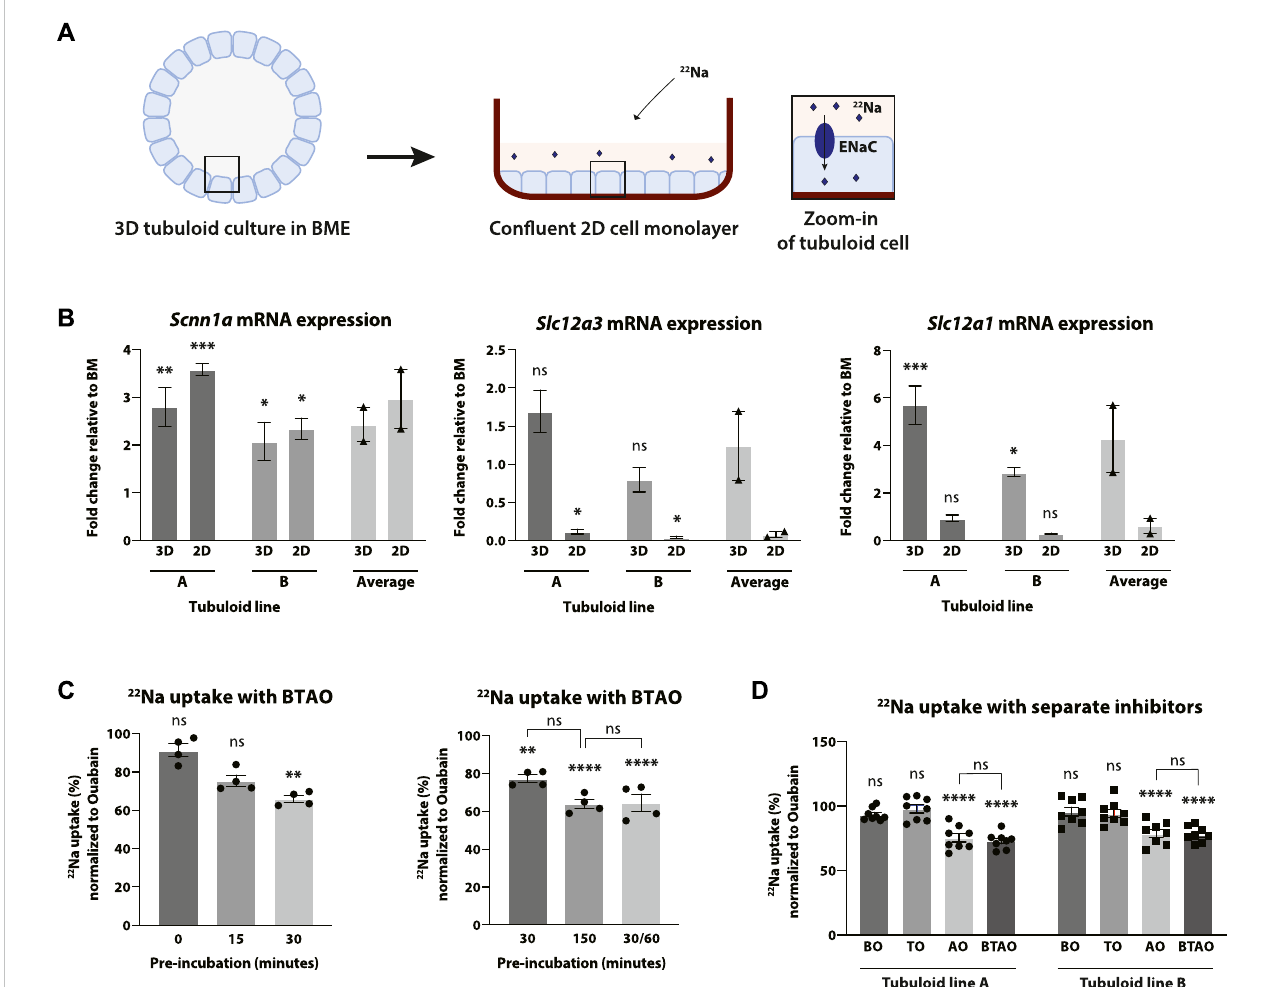
FIGURE 5 CD-enrichedmousetubuloidsshowENaC-mediateduptakeofradioactive 22 Na.Schematicexplainingthedifferencebetween3Dand2Dinsubsequent images ofthis fi gure.Tubuloids grown in 3Din aBME gelare formedinto a single cell suspension, seeded and expanded into a2D cell monolayer followedby CDstimulation(seealsoFigure1).The2Dcellmonolayerallowsforapicalaccessof 22 NatoENaCforuptakeexperiments.ApicallocationofENaCandentryof 22 Na in the uptake experiment is schematically shown in the zoom-in of the tubuloid cell (A) . Fold change of ENaC ( Scnn1a ), NCC ( Slc12a3 ) and NKCC2 ( Slc12a1 ) mRNA expression levels in tubuloid lines A and B after 2D and 3D CD stimulation compared to 2D BM culture ( N = 2 duplicates). Average of the 2 tubuloid lines is included ( N = 2 duplicates) (B) . Uptake of radioactive 22 Na by tubuloid lines after CD stimulation (C, D) . Uptake of 22 Na in tubuloid line A was tested after pre-incubation periods of 0, 15, 30, and 150 min with 30 min experiment or 30 min pre-incubation with 60 min experiment (30/60). Uptake mediumcontainedmultipleinhibitorsoftransporters;bumetanide(NKCC2),hydrochlorothiazide(NCC)andamiloride(ENaC)( N =4replicates) (C) .Theeffect of transport inhibitors bumetanide (BO), hydrochlorothiazide (TO) and amiloride (AO), separately, in tubuloid lines (A, B) was compared to the combination of theseinhibitors(BTAO)( N =8replicatesfromtwoindependentexperiments) (D) .Allexperimentalconditionsincludeincubationwithouabain(O),aninhibitor oftheNa + /K + -ATPase. Results arenormalizedto thecondition with onlyouabain (C,D) . ns,not signi fi cant; * p < 0.05, ** p < 0.01, *** p < 0.001,**** p < 0.0001. 3D, three-dimensional; BME, basement membrane extract; 2D, two-dimensional; ENaC, epithelial sodium channel; NKCC2, Na + , K + , chloride (Cl − ) cotransporter; NCC, Na + , Cl − cotransporter; CD, collecting duct; BM, basal medium; Na + , sodium; K + ,